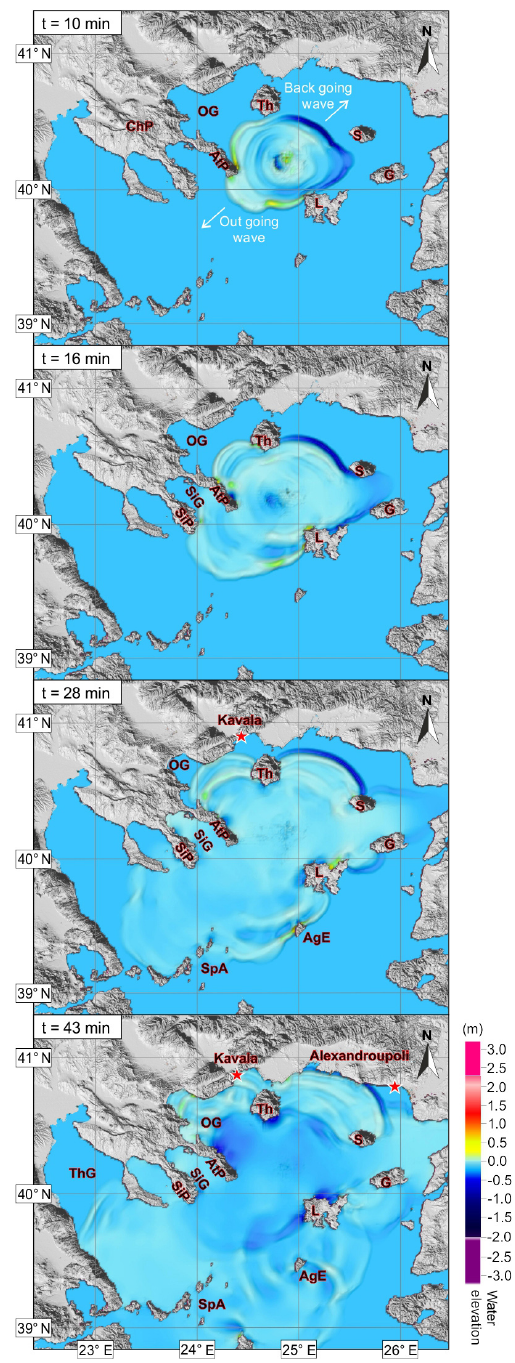
Figure 7. Tsunami propagation in the case of the second credible scenario ( e w of 5 × 10 − 4 and a basal friction angle of 1 . 5 ◦ ; Table 1). AgE is Agios Efstratios, AtP is Athos peninsula, G is Gokceada, L is Lemnos, OG is Gulf of Orfani, S is Samothrace, SiG is Sigitikos Gulf, SiP is Sithonia peninsula, SpA is Sporades archipelago, Th is Thasos and ThG is Thermaic